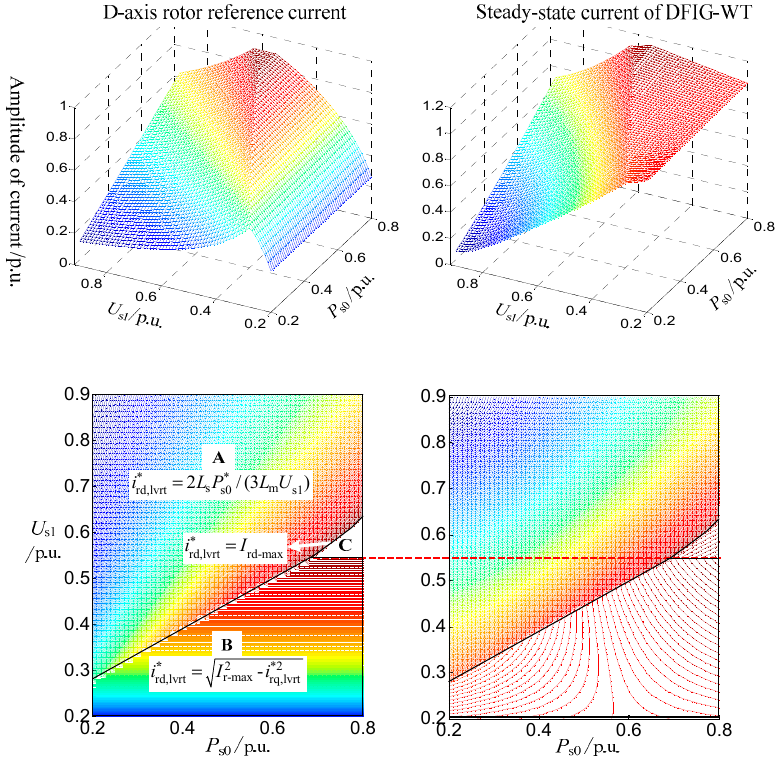
Figure 4. Characteristics of steady-state components of DFIG-WT fault current.